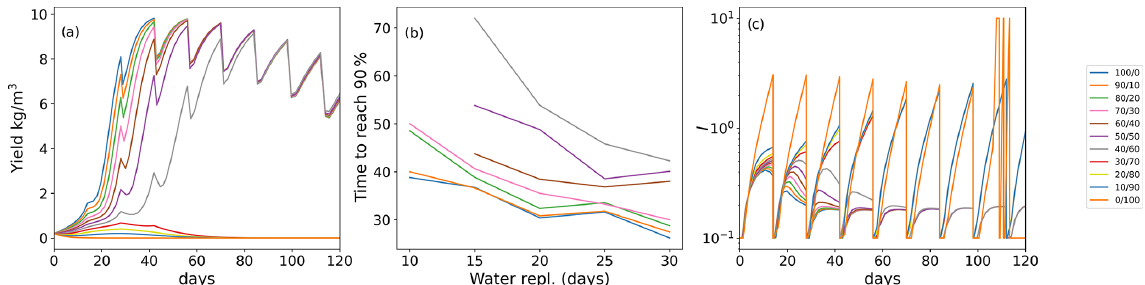
Figure 3. (a) Yield (biomass gain in kgm − 3 up to the limit of 10kgm − 3 in a bioreactor with a starting density of 0.2gm − 3 ) for populations with various initial age mixes (% of young/old thalli) with 14d water replacement frequency. (b) Inhibitor ( I ) production in the population of the time with 14d of water replacement frequency. (c) Ulva biomass growth kinetics as a function of the initial age distribution of thalli in the population with various frequencies of water replacement.